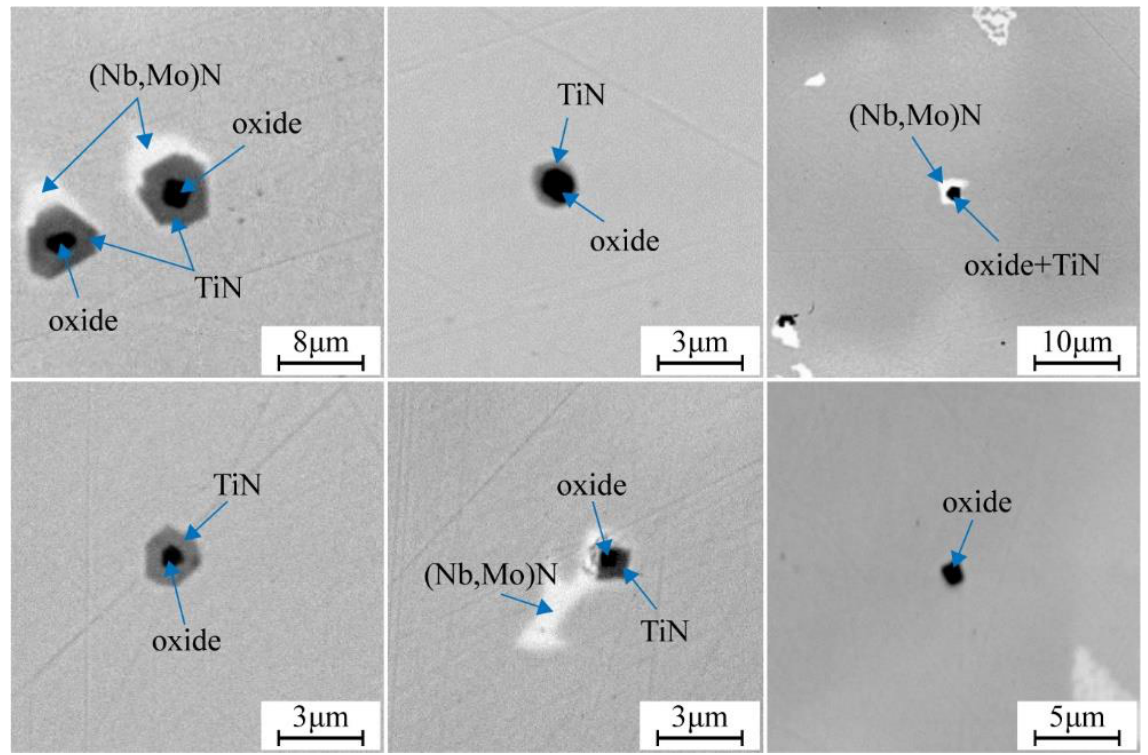
Figure 9. Typical inclusions in the melt during the refining period.